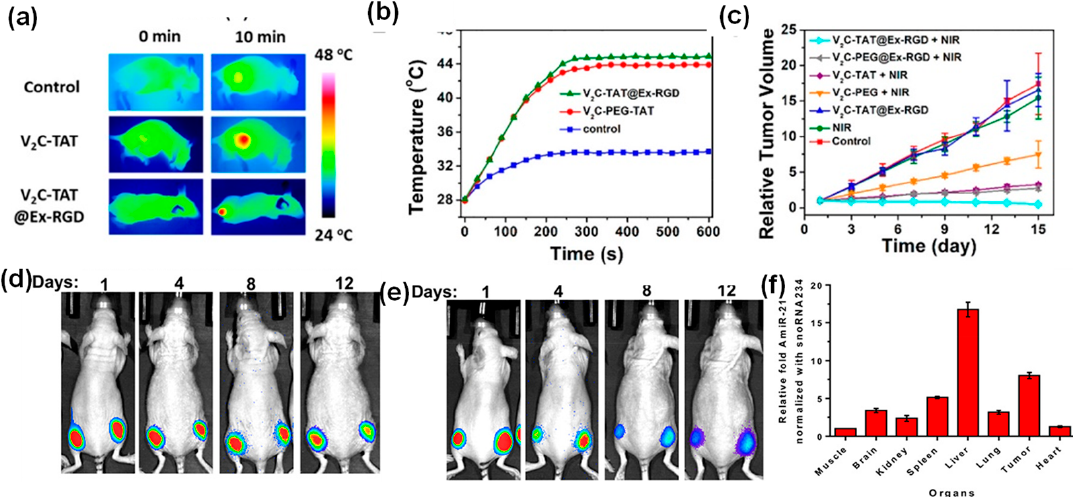
Figure 6. ( a ) IR thermal images and ( b ) the corresponding temperature changes at the tumor sites of MCF-7 tumor-bearing mice under 1064 nm laser irradiation. ( c ) Relative tumor growth curves of the MCF-7 tumor-bearing mice in different groups [30]. ( d–f ) In vivo bioluminescence imaging for the 14-day growth of xenografts of 4 T1 -Fluc-eGFP cells implanted in nude mice post administration of Au-Iron oxide nanoparticle-loaded exosomes. ( d–f ) In vivo biodistribution and anti-tumor properties of tumor cell derived exosomes loaded with Au-iron oxide nanoparticles and anti-miR-21 in combination with DOX. The bioluminescence images of animals treated with exosomes without DOX ( d ) and with DOX ( e ) at days 1, 4, 8, and 12, ( f ) biodistribution of anti-miR-21 in different organs of animals 12 days after treatment with 3 consecutive doses (days 1, 4, and 8) [46].